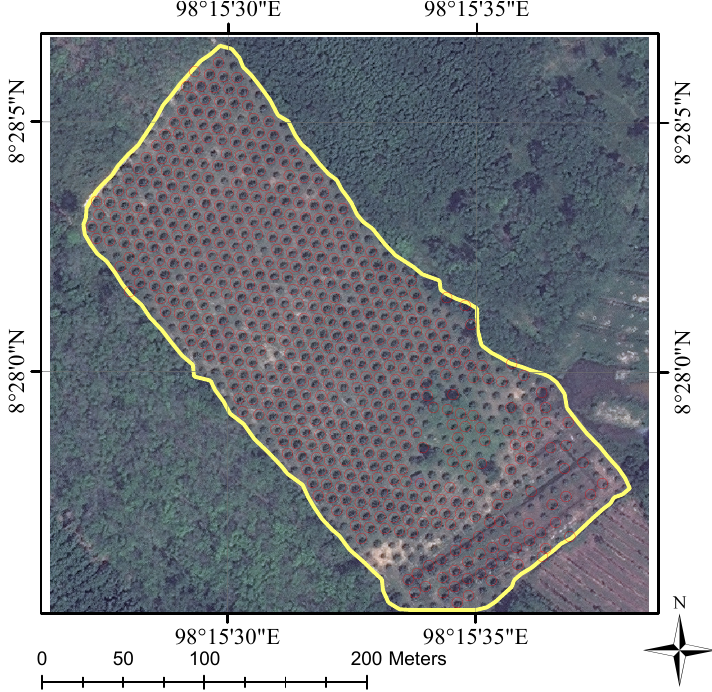
Figure 11. The oil palm detection result on the test area shown in Figure 4a without using rank transformation on index image. Note that the diameter of red circles has no relationship with the diameter of tree